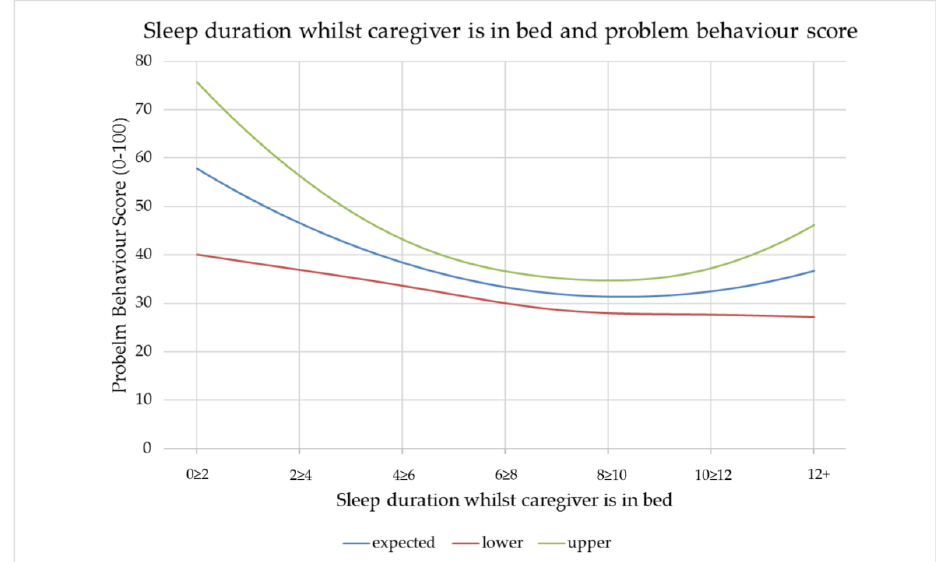
Figure 3. The relationship between sleep achieved by a dog whilst their caregiver is in bed and PBS. “Expected” represents the expected value from this sample. “Lower” and “upper” represent the bounds of a 95% confidence interval on these expected values.